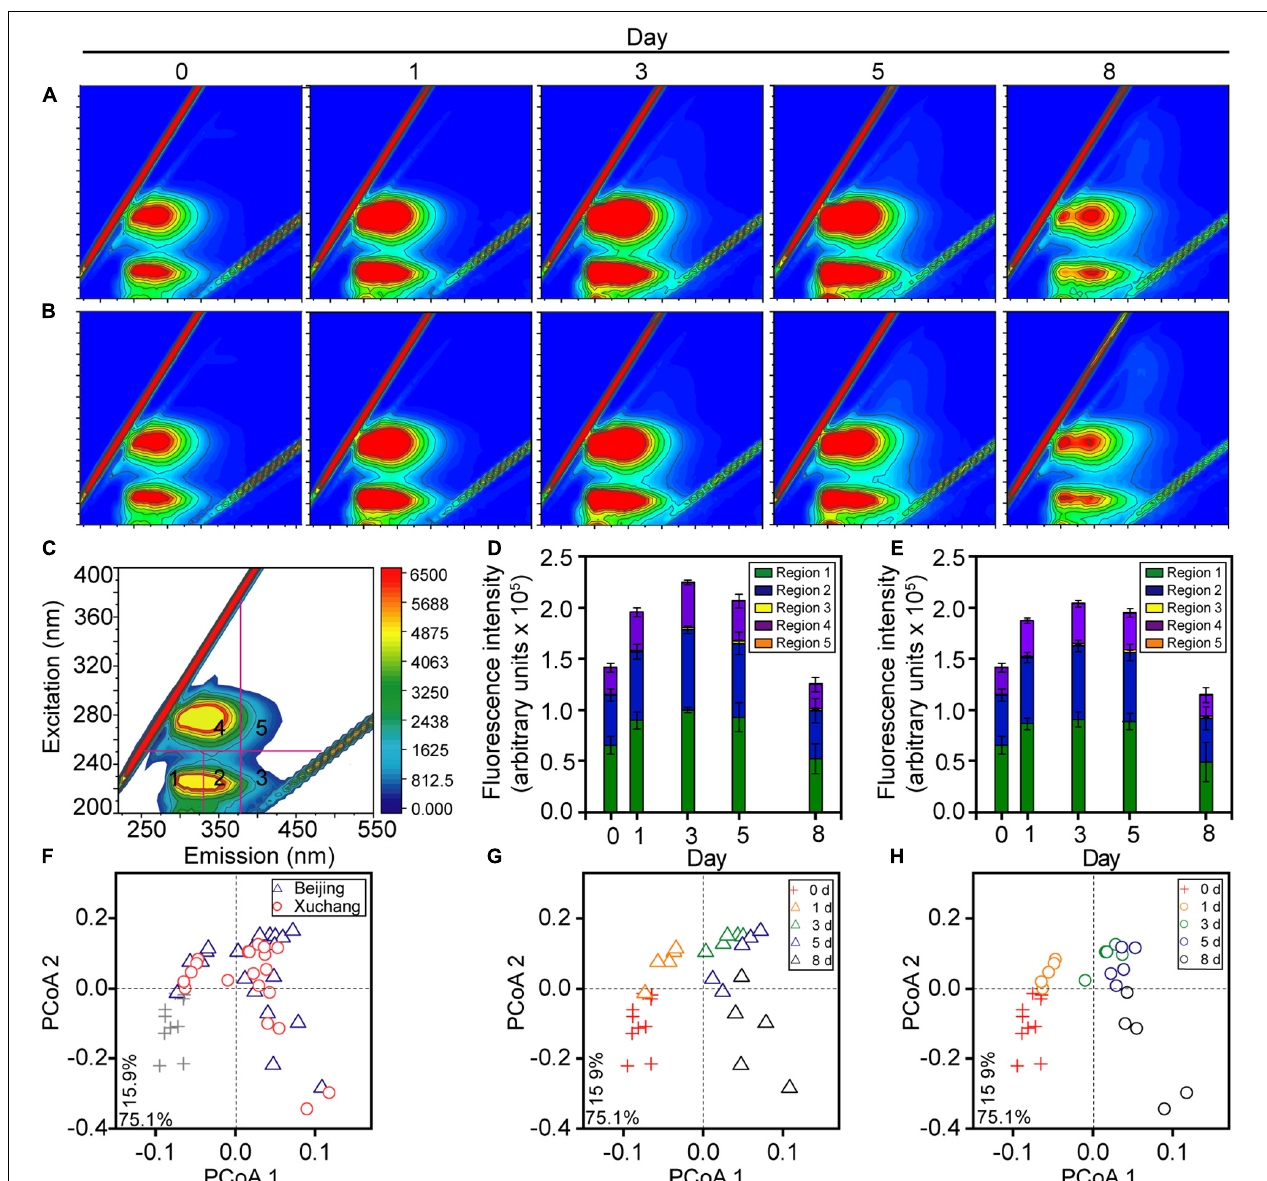
FIGURE 2 | The dissolved organic matter (DOM) composition of decaying earthworm changed during decomposition in native soil and non-native soil. Representative excitation-emission spectra of DOM in native soil (A) and non-native soil (B) . Five fractions in excitation-emission spectra (C) : tyrosine-like proteins (region 1), tryptophan-like proteins (region 2), fulvic acid-like organics (region 3), microbial byproduct-like materials (region 4), and humic acid-like organics (region 5). The color refers to increasing of fluorescence intensity from blue to red in A–C . The amount of total DOM and all five fractions showed a clear temporal pattern either in native soil (D) or non-native soil (E) . The shifts of DOM composition over time were visualized in the principal coordinate analysis (PCoA; F–H ) based on the Bray–Curtis distance of excitation-emission spectra. The triangles indicate the samples in native soil (Beijing), circles indicate those in non-native soil (Xuchang), and the crosses indicate the samples in native soil and non-native soil at day